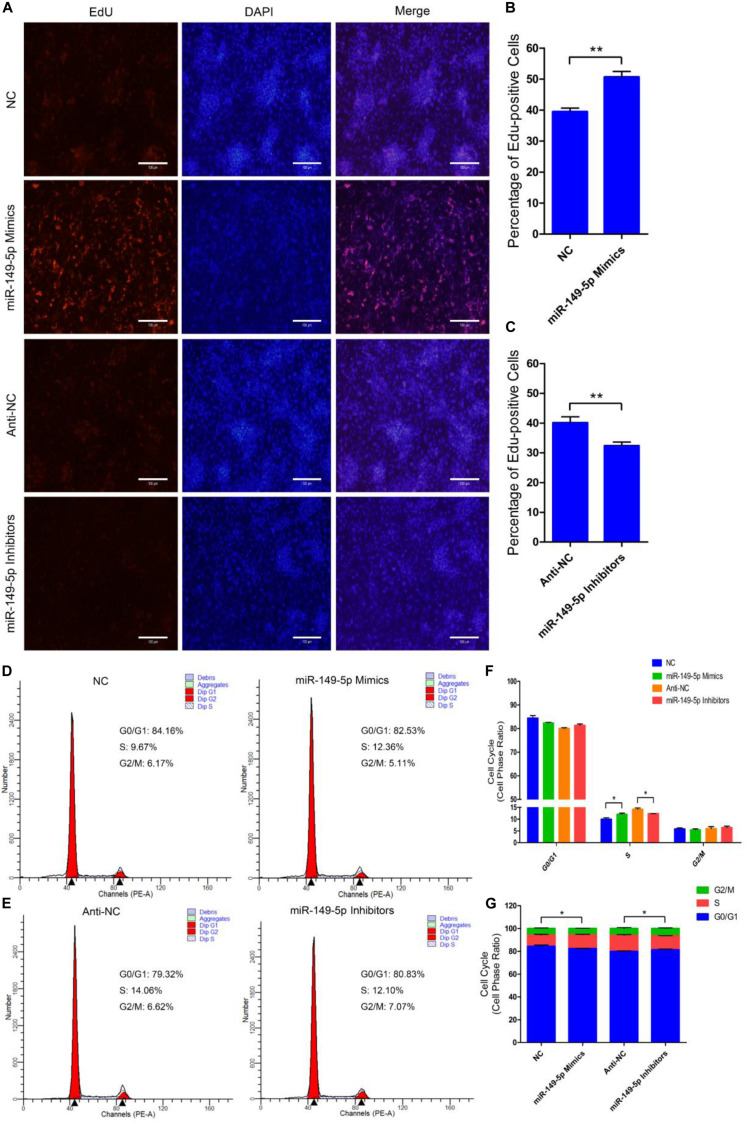
miR-149-5p accelerates goat hair follicle stem cell proliferation. (A) Representative images of the EdU assay of hair follicle stem cells at 24 h after transfection with NC, miR-149-5p mimics, anti-NC, and miR-149-5p inhibitors in GM. Bars, 100 μm. (B,C) Quantification of EdU-positive cells (n = 6). The ratio of EdU-positive cells was calculated as (EdU-positive cells/Hoechst stained cells) × 100%. (D–G) Hair follicle stem cells were transfected with NC, miR-149-5p mimics, anti-NC, and miR-149-5p inhibitors in GM, and cell cycle phases were analyzed at 48 h after transfection by flow cytometry (D,E) and counted (F,G). The results from each group are shown as the mean ± SEM of three independent replicates. Independent-samples t-tests were used for statistical analysis. Asterisks indicate significant differences. No asterisk means P > 0.05, *P < 0.05, and **P < 0.01.